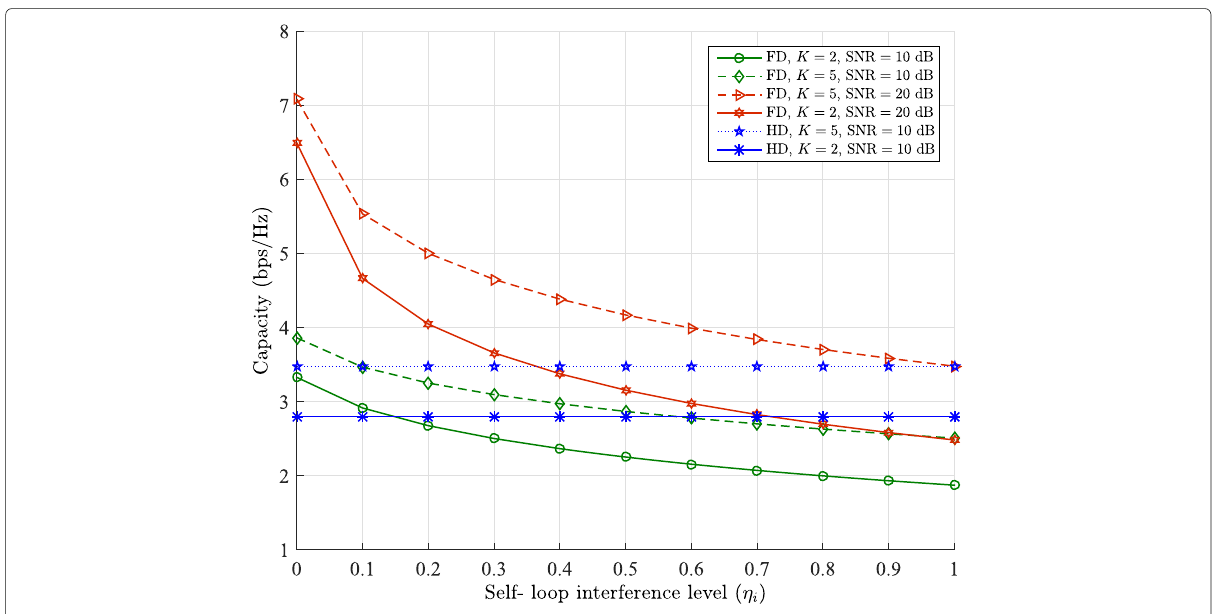
Fig. 6 Capacity performance of the FD and HD relay systems versus η i